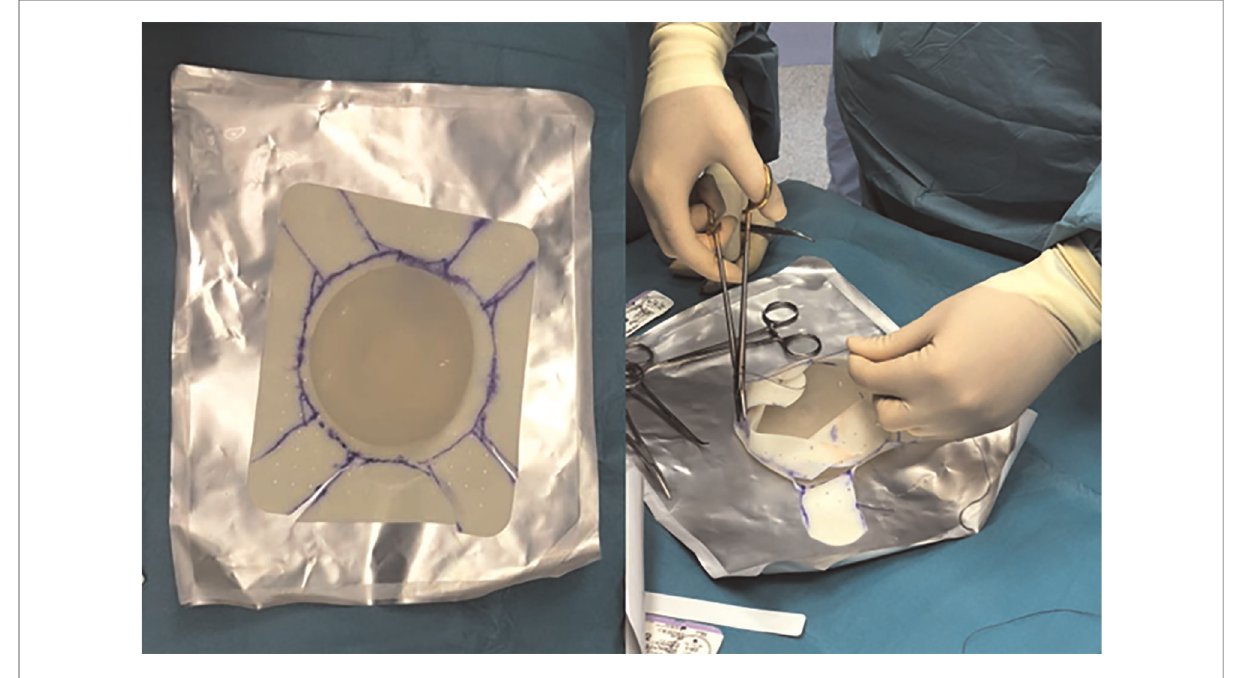
FIGURE 4 ADM cut to better adapt to the prosthesis and its fi xation with stitches.